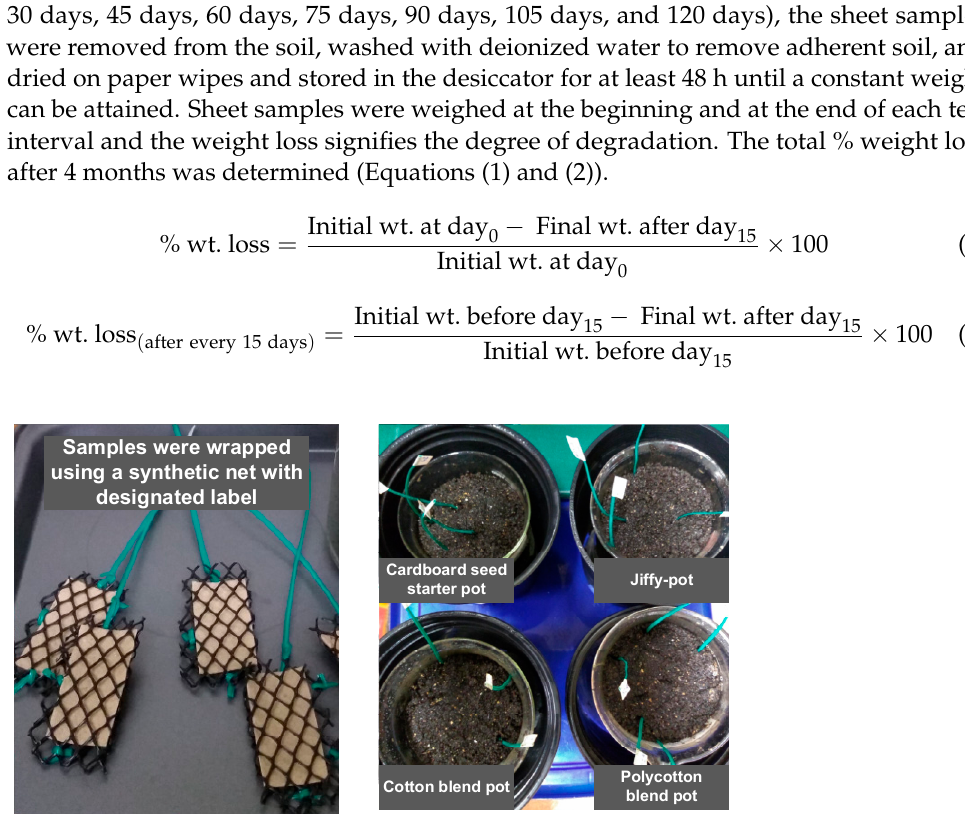
Figure 6. Soil burial test using different seedling pots.